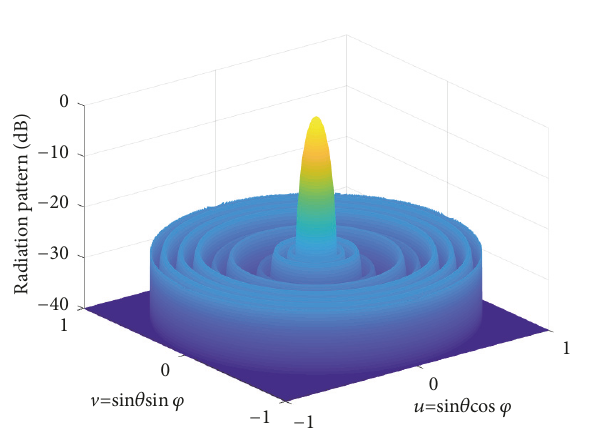
Figure 5: Radiation pattern of the optimal result.